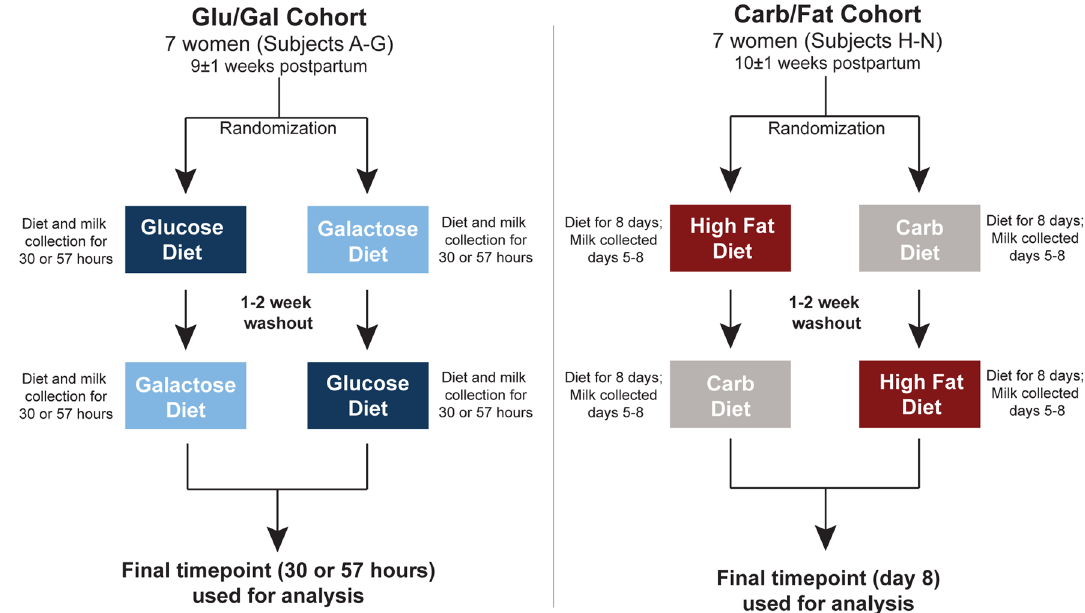
Figure 1. Study design: single-blinded cross-over dietary intervention studies. Two separate single-blinded cross-over dietary intervention studies were performed to evaluate the impact of maternal diet on human milk. In the first study (Glu/Gal Cohort, left), lactating women 8–11 weeks postpartum were randomly assigned to receive a liquid, isocaloric, isonitrogenous drink containing either glucose or galactose as the sole carbohydrate source for a total of 30–57 h. The sugar treatment provided 60% of their daily estimated energy requirement, and a standardized mix of protein and essential fatty acids were provided to supplement the treatment. Milk samples were collected as specified, and following a 1–2 week washout period each woman received the alternative treatment (random initial allocation); thus paired milk samples were collected from each subject, allowing each subject to serve as her own control. In the second study (Carb/Fat Cohort, right), a second cohort of 7 different lactating women 9–12 weeks postpartum were randomly assigned to receive either a high fat (55% fat, 30% carbohydrate, 15% protein) or carbohydrate (25% fat, 60% carbohydrate, 15% protein) diet for 8 days consisting of packed meals with isocaloric, isonitrogenous nutrient compositions. The milk samples collected at the completion of each dietary treatment were used for analysis. Postpartum age ranges indicate mean ± standard